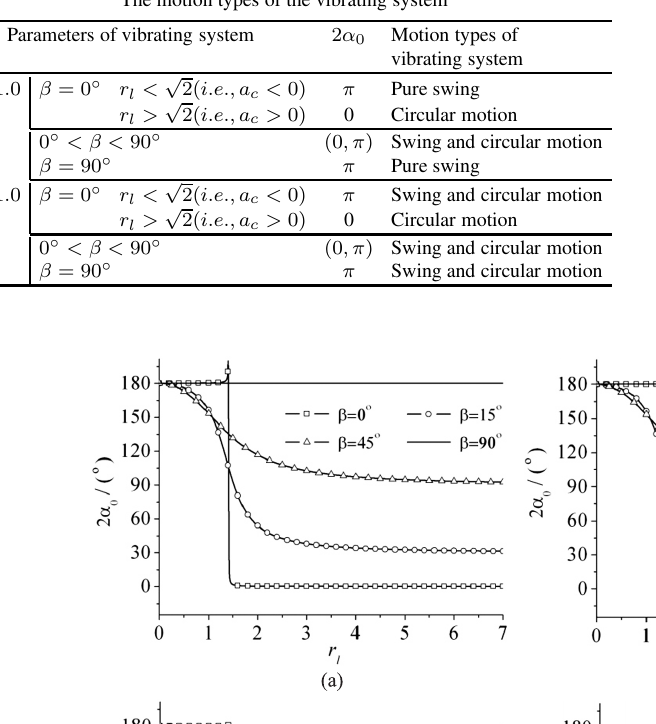
Table 1 The motion types of the vibrating system